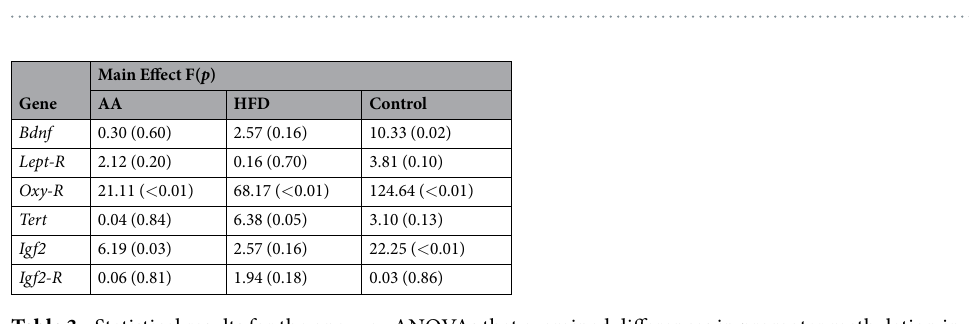
Table 2. Results from the one-way ANOVAs examining promoter methylation in the sperm obtained from fathers and their sons.